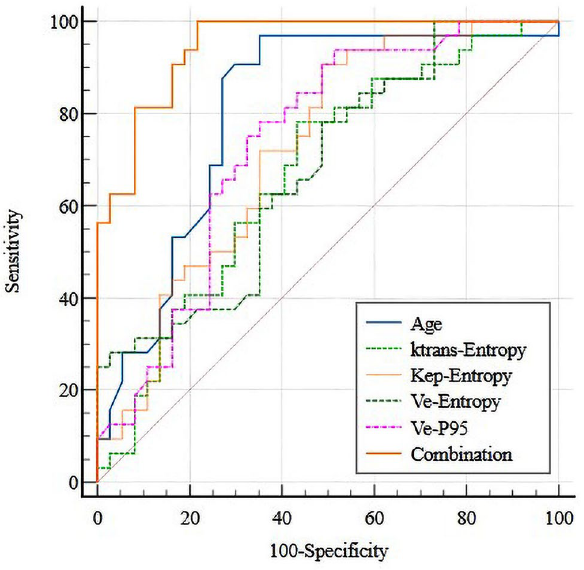
Figure 4. ROC curve of DCE-MRI quantitative parameters in differentiating between thymic cancer and thymic lymphoma